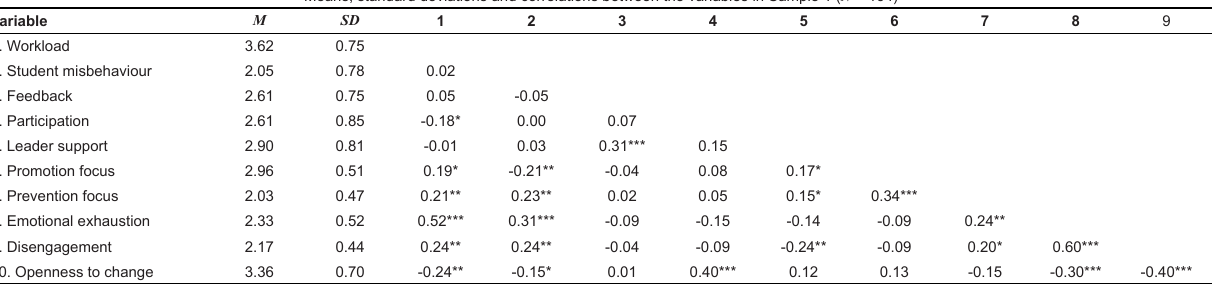
TABLE 1 Means, standard deviations and correlations between the variables in Sample 1 ( N = 164)